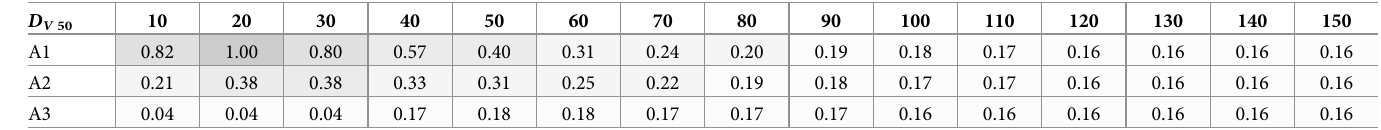
Table 2. Optimal configuration mixing surface area deposition coverage and deposition efficiency in the olfactory